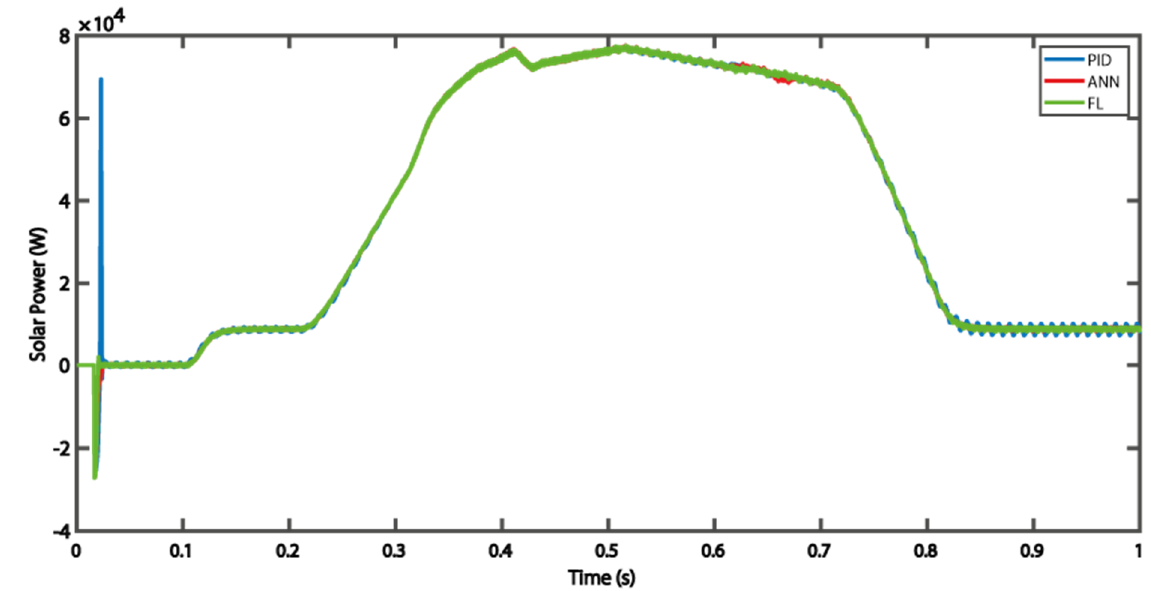
Figure 16. The power produced from PV panels (W).